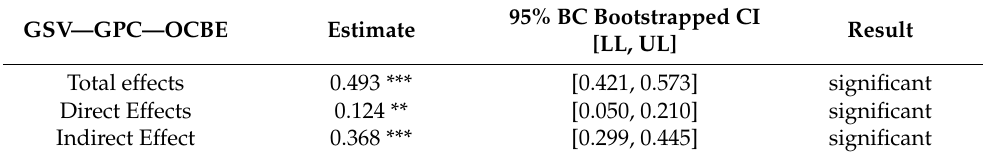
Table 4. Mediational analysis ( n =